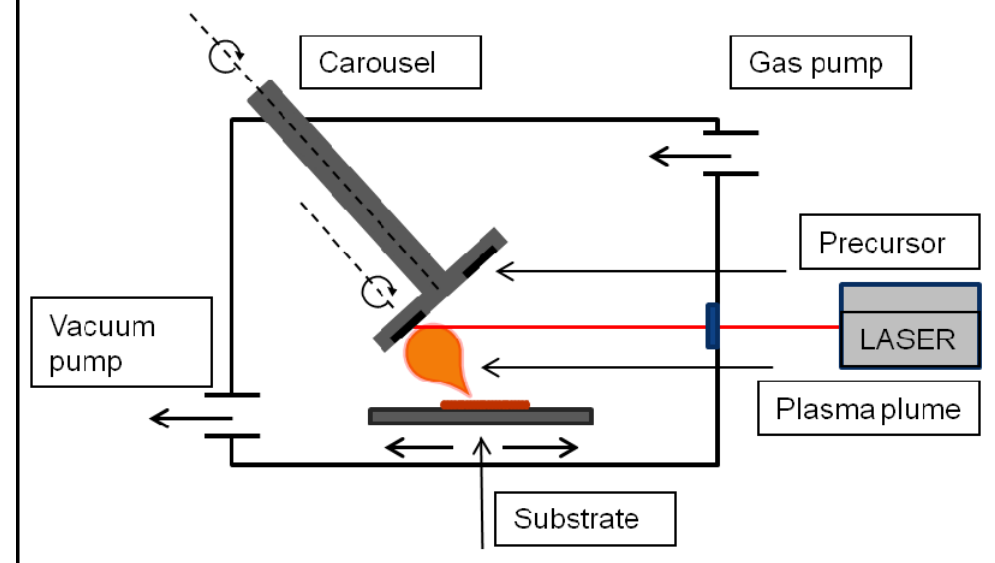
Figure 3. Schematic representation of the pulsed laser deposition (PLD) coating